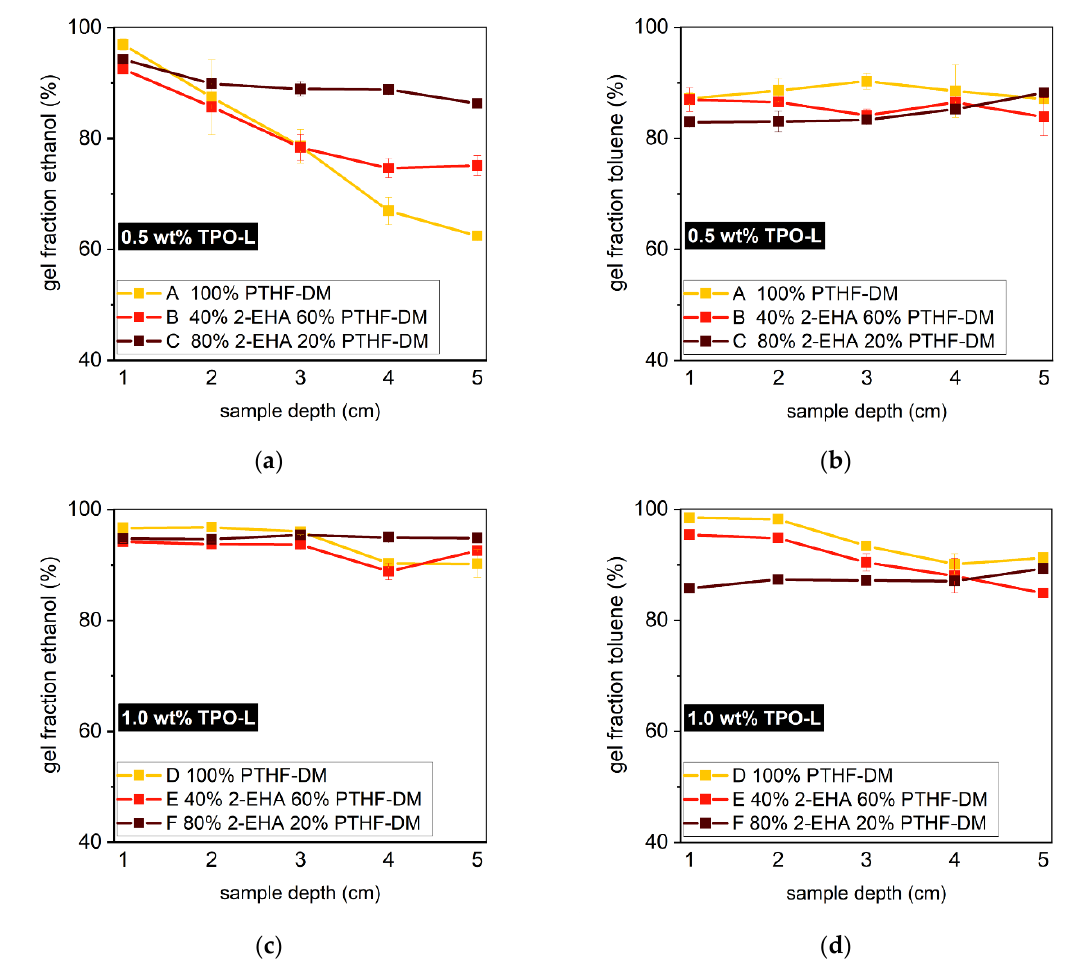
Figure 11. ( a ) Characteristics of the monomer composition play a key role in curing. For polymerization with 0.5 wt % TPO-L, a high quantity of 2-EHA appears beneficial. Gel contents below 90% are observed in toluene, though with high consistency ( b ). Regardless of the monomer composition and solvent, homogenous through-cure and uniform gel content are achieved using 1.0 wt % of photoinitiator ( c , d ).